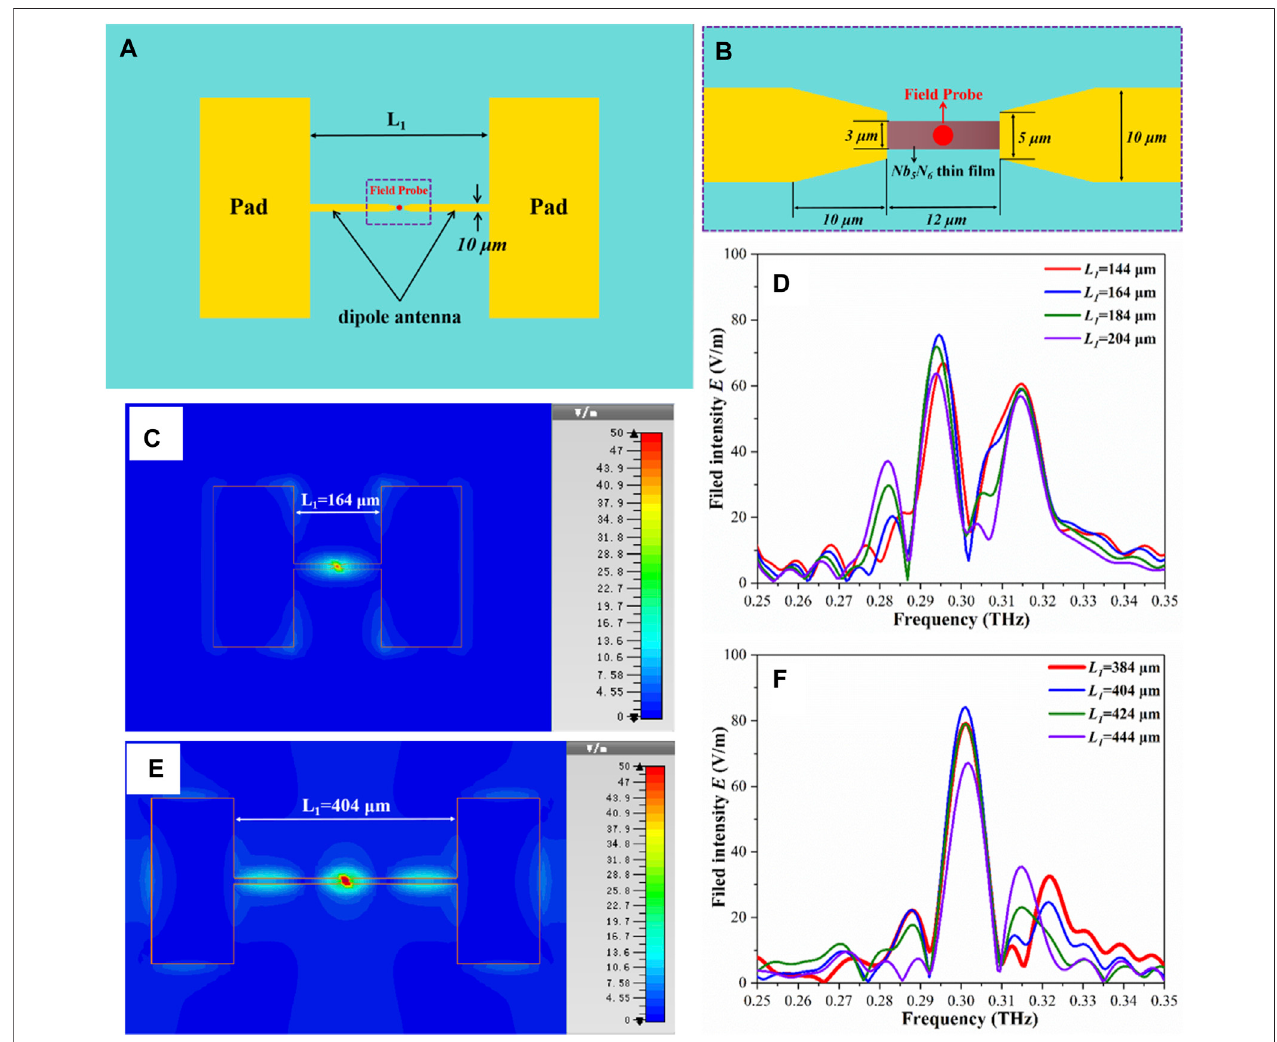
FIGURE1|(A) SchematicdiagramoftheplanardipoleantennaontheSisubstrate. (B) ThelocationandsizeoftheNb 5 N 6 fi lmintheplanardipoleantenna. (C) The electric fi eld intensity distribution of the half-wave dipole antenna with L 1 (cid:2) 164 μ m at 0.295 THz. (D) The electric fi eld intensity varies with L 1 in the half-wave dipole antenna in the range of 0.25 – 0.35 THz. (E) The electric fi eld intensity distribution of the full-wave dipole antenna with L 1 (cid:2) 404 μ m at 0.301 THz. (F) The electric fi eld intensity varies with L 1 in the full-wave dipole antenna in the range of 0.25 – 0.35